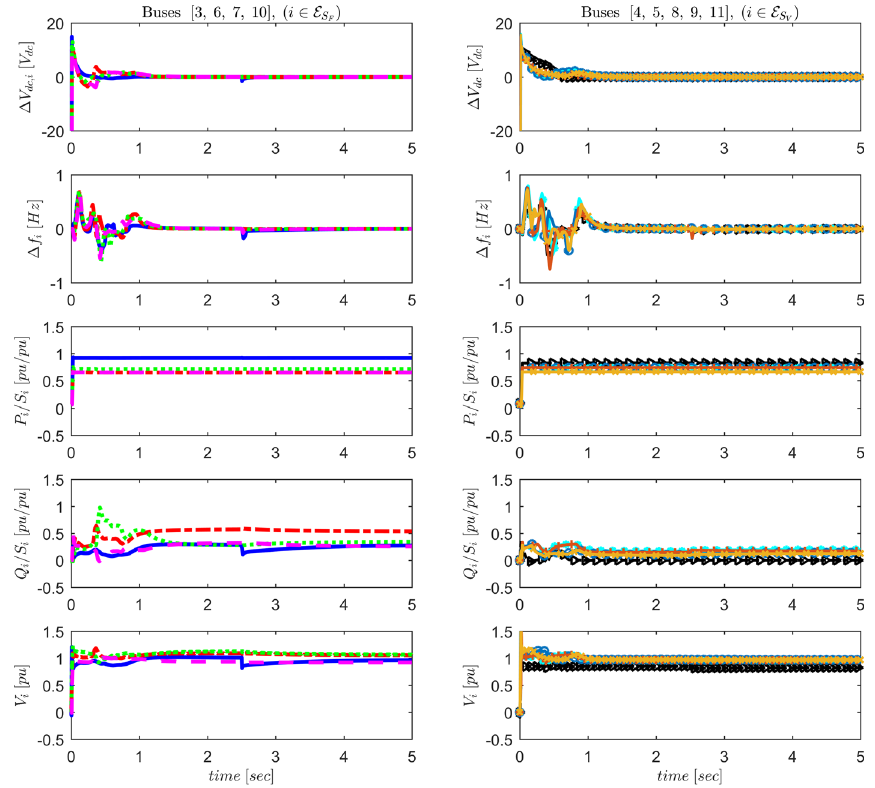
Fig. 14 Transition between islanded and grid-connected modes. The switching between slanded and grid-connected modes is occurred at time 2.5 sec . The microsource dynamic responses including dc voltage tracking, frequency synchronization, the power sharing as well as ac voltage tracking (amplitudes at output terminals). The lines correspond to the microsources at: bus 3, ’–’, bus 6, ’- -’, bus 7, ’..’, bus 10, ’-.’. Moreover, the lines correspond to other microsources at: bus 4, ’ > -’, bus 5, ’+-’, bus 8, ’x-’, bus 9, ’o-’, bus